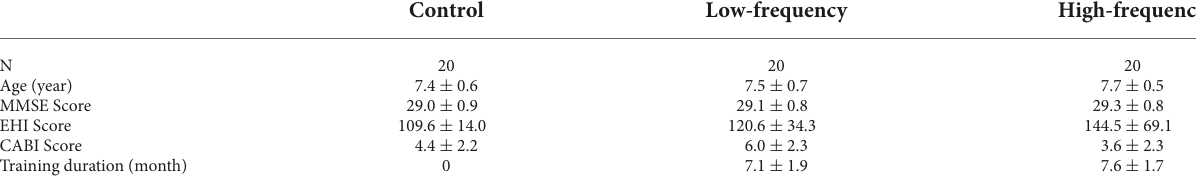
TABLE 1 Participant demographics (Mean ±